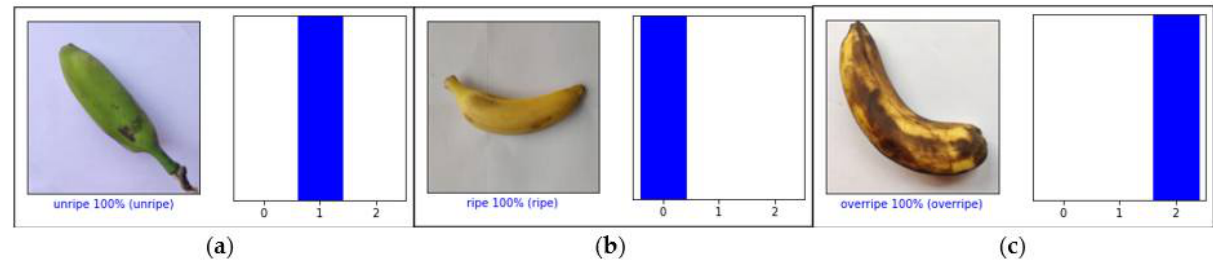
Figure 9. The proposed model results for ( a ) unripe, ( b ) ripe, and ( c ) over-ripe.